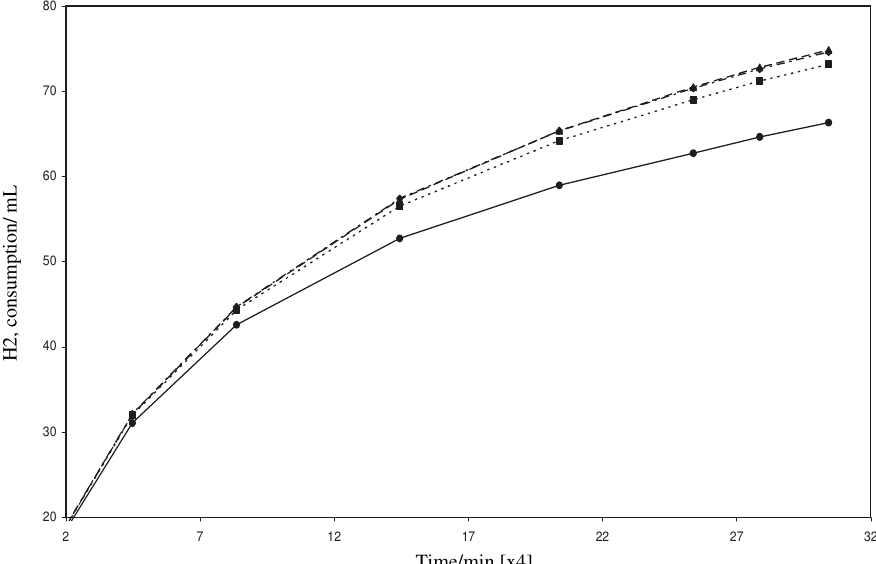
Figure 7. Palm oil hydrogenation with different catalysts. Reaction condition: palm oil, 1% w/w; solvent, butan-1-ol; initial pressure, 30 atm; temp. 573K( ■ ) Ni-ZSM-5; ( ● ) Cu-ZSM-5 ( ♦ )